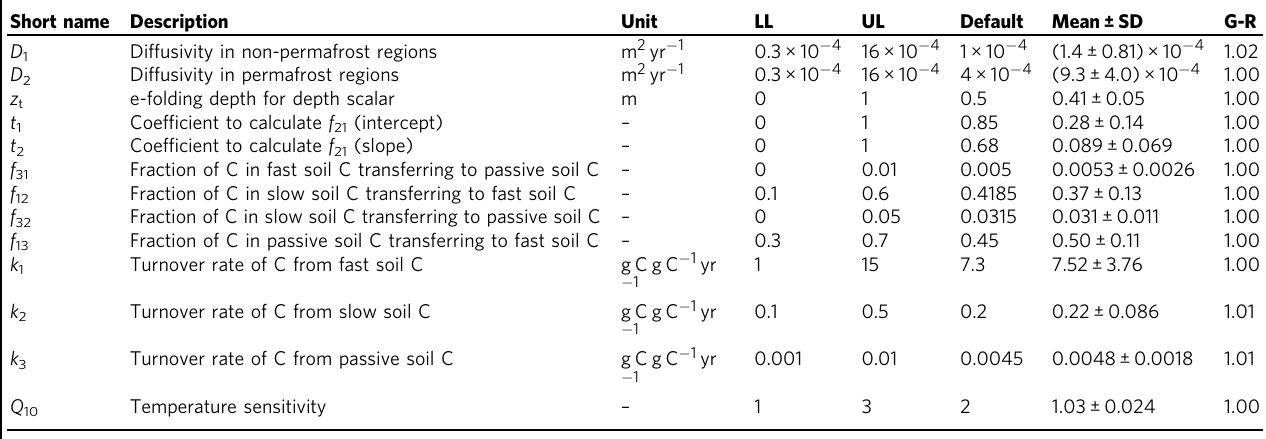
Table 2 Descriptions of parameters in the vertically resolved model Short name